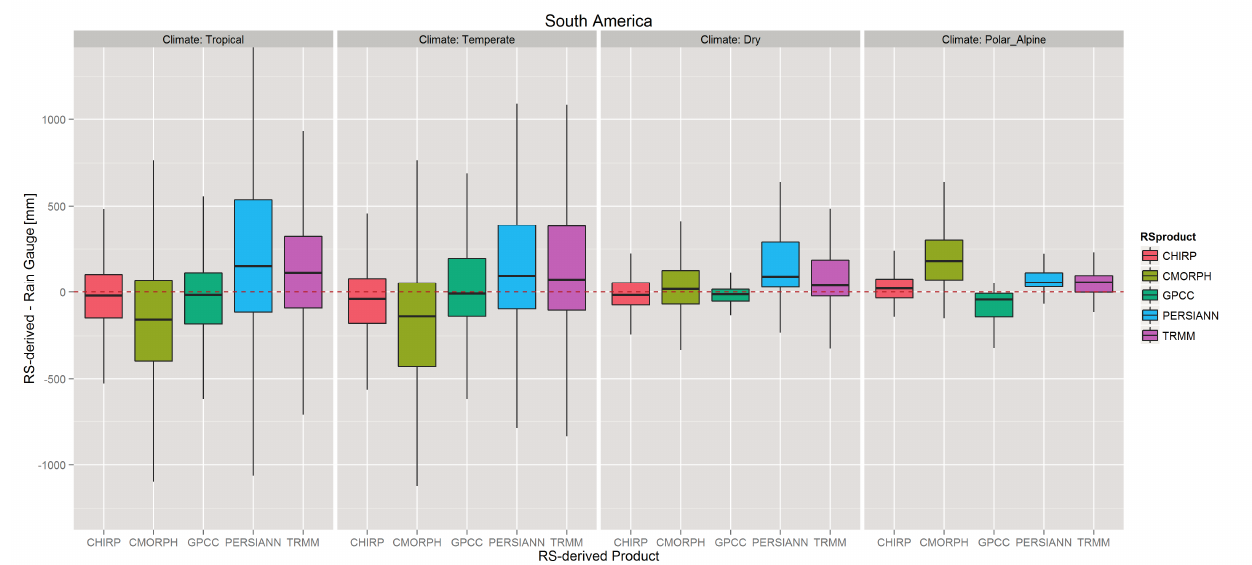
Figure 10. Box-and-Whiskerplot of the difference between downscaled and observed precipitation for different climate classes across the entire South